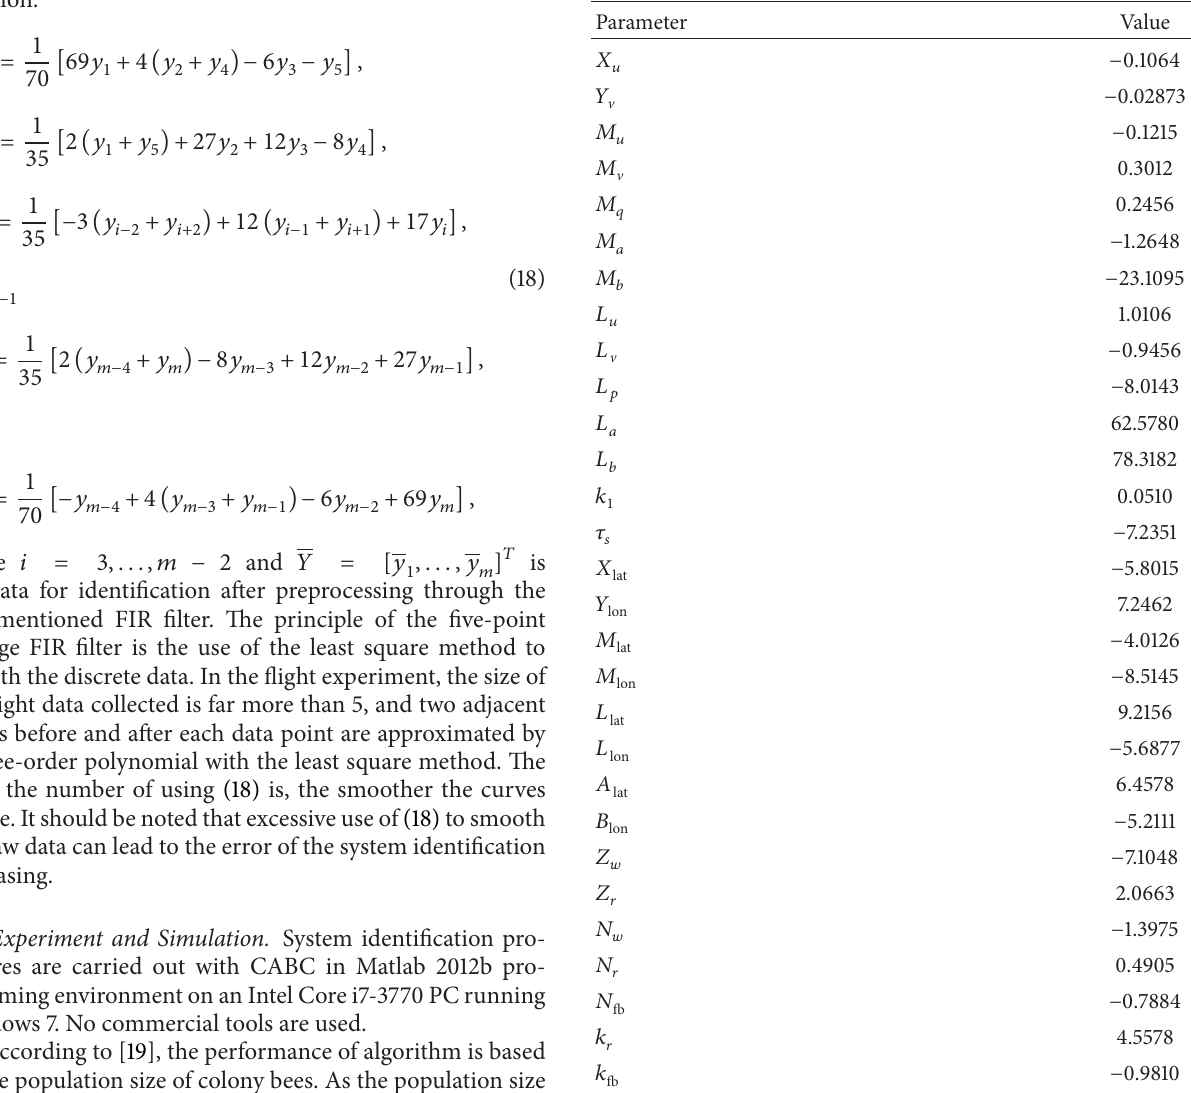
Table 5: The values of identified